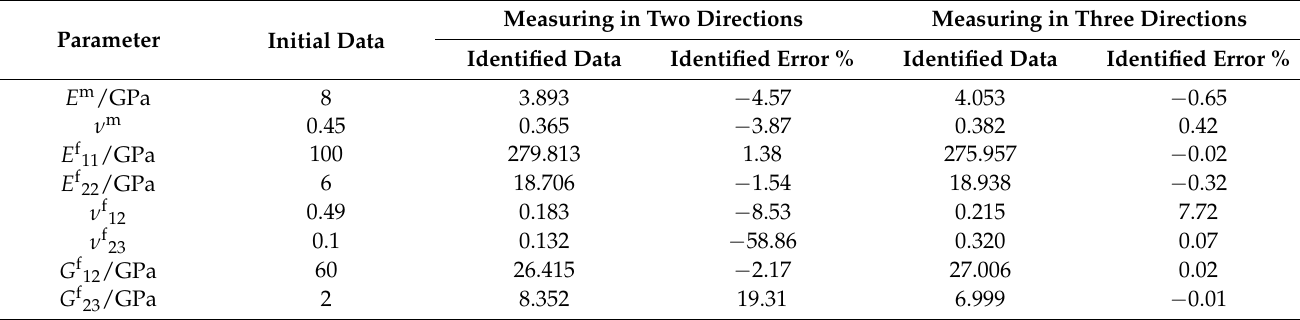
Table 8. Identified constituent parameters of composite panel (0.5% noise).